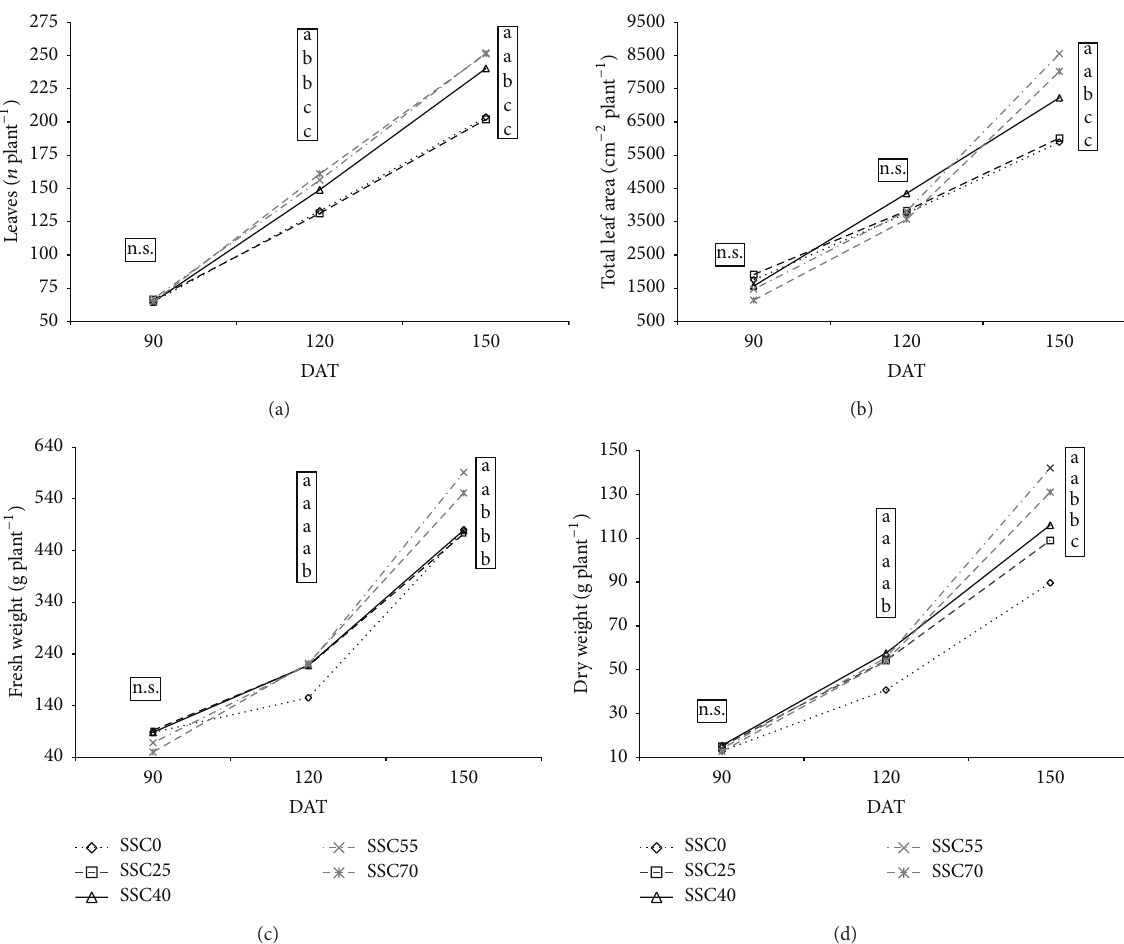
Figure 1: Leaves number (a), leaf area (b), fresh (c), and dry (d) weight in Bougainvillea potted plants at 90, 120, and 150 DAT as influenced by growing media. Each point is the mean of three replications. Within the same DAT values with the same letter are nonsignificantly different 𝑃 ≤ 0.05